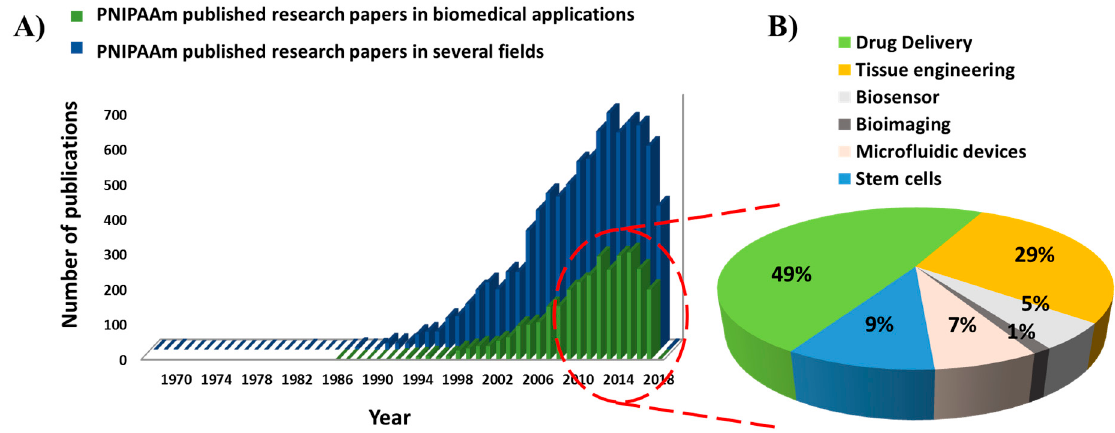
Figure 1. ( A ) Evolution of published research articles about poly( N -isopropylacrylamide) (PNIPAAm) and its application in biomedical and other fields, per year; and ( B ) Percentage of PNIPAAm published research articles in biomedical field, classified by application. Database used for the bibliographic analysis: Scopus ® (Elsevier, Amsterdam, The Netherlands).